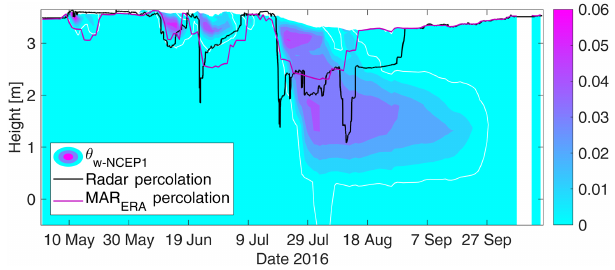
Figure 9. Simulated percolation depths compared with upGPR de- rived percolation (black line). The color bar presents volumetric liq- uid water content from MAR-NCEP1 with 1vol% contour inter- val. The thin white line delineates interpolated water content below 0.1vol% as approximate of the borders of the simulated wetting